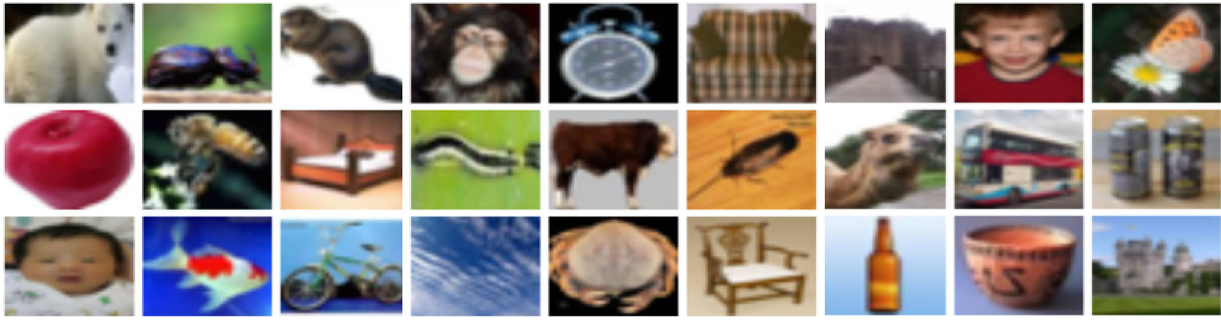
Fig. 6 Cifar 100 dataset sample